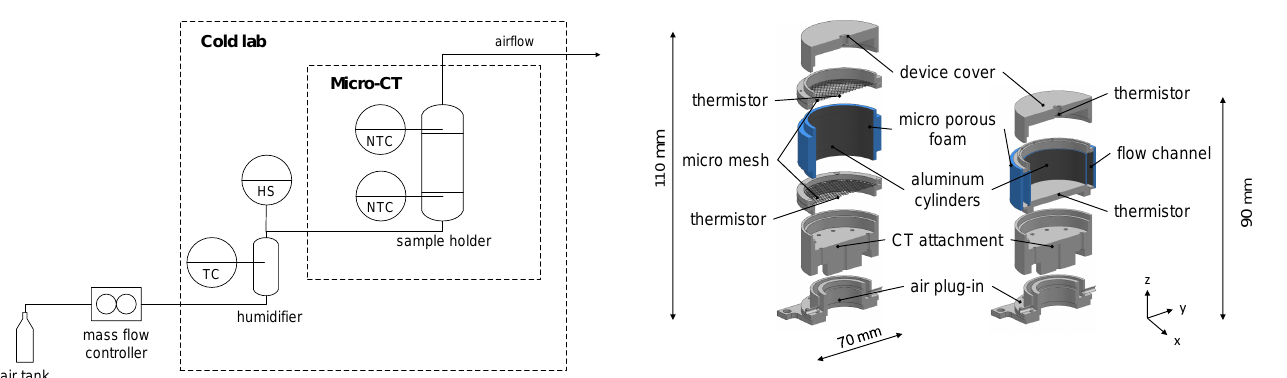
Figure 1. Schematic of the experimental setup. A thermocouple (TC) and a humidity sensor (HS) inside the humidifier measure the airflow condition. Two thermistors (NTC) close to the snow surface measure the inlet and outlet temperature of the airflow.